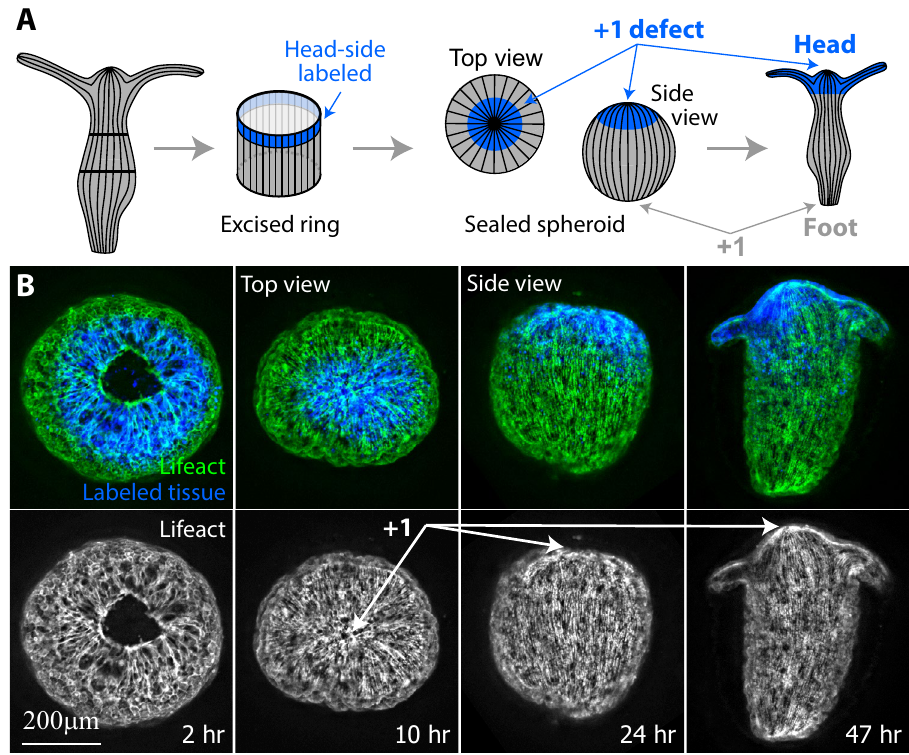
Figure 4. Actin fiber organization in a single regenerating ring. ( A ) Schematic illustration of the ectodermal actin fiber organization during regeneration of an excised ring. Left: The actin fibers in a mature Hydra are arranged in a parallel array, along the direction of the body axis. Middle left: An excised ring inherits this actin fiber organization. The region at the oral-facing end of the excised ring is labeled (blue). Middle right: the excised ring closes into a spheroid by sealing the open ends at its top and bottom sides. Two aster-like defects form at both ends of the sealed spheroid. Right: The excised ring regenerates into an animal with a new head forming at the defect site located at the originally head-facing (labeled) side of the excised ring, and a new foot forming at the other end. ( B ) Spinning-disk confocal images from a time-lapse movie of an excised ring that is labeled at its oral-facing end (Movie 7). The labeling is done by locally uncaging an electroporated caged-dye (Abberior CAGE 552; see “Methods”) 32 . Images are shown at frames providing a top view of the regenerating ring from its edge (left images) or a side view of the tissue (right images) at different time points during the regeneration process. Bottom: The projected lifeact-GFP signal (“Methods”) showing the organization of the ectodermal actin fibers. The aster-like (+ 1) defect at the edge of the sealed spheroid is clearly visible from the top view, and coincides with the site of formation of the new organizer at the tip of the hypostome of the regenerated animal. Top: Overlay of the lifeact-GFP signal (green) and the fluorescent tissue label (blue) that marks the tissue originating from the oral-facing side of the excised